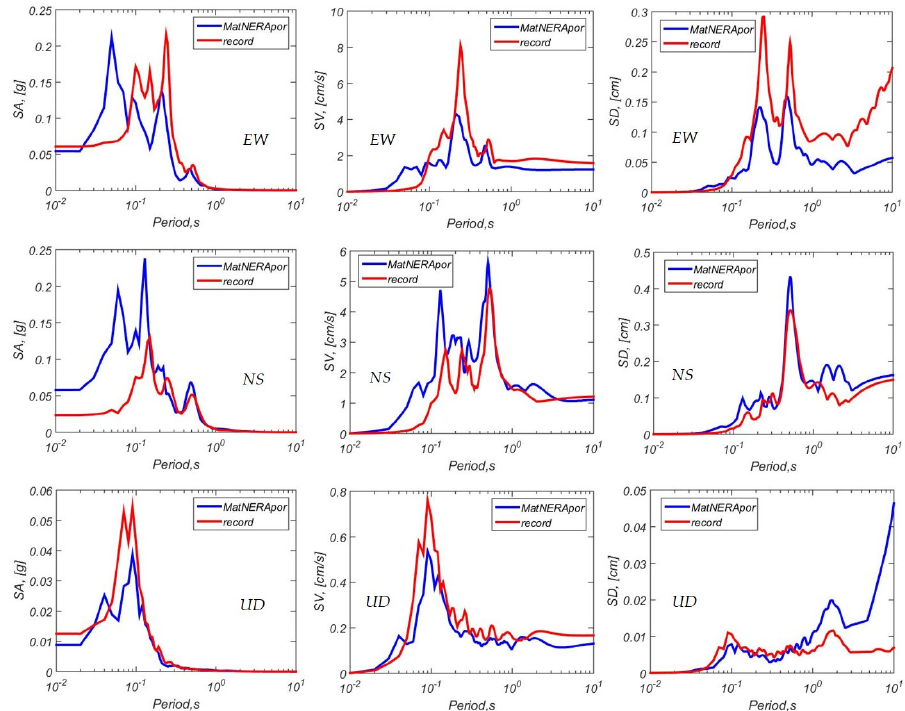
Figure 9. Comparison of response spectra (damping 5%) of modeled and recorded accelerograms (components EW, NS, UD; spectral acceleration—SA, spectral velocity—SV, spectral displacement—SD) calculated for the surface of soil layers at Kik-net site TCGH15.